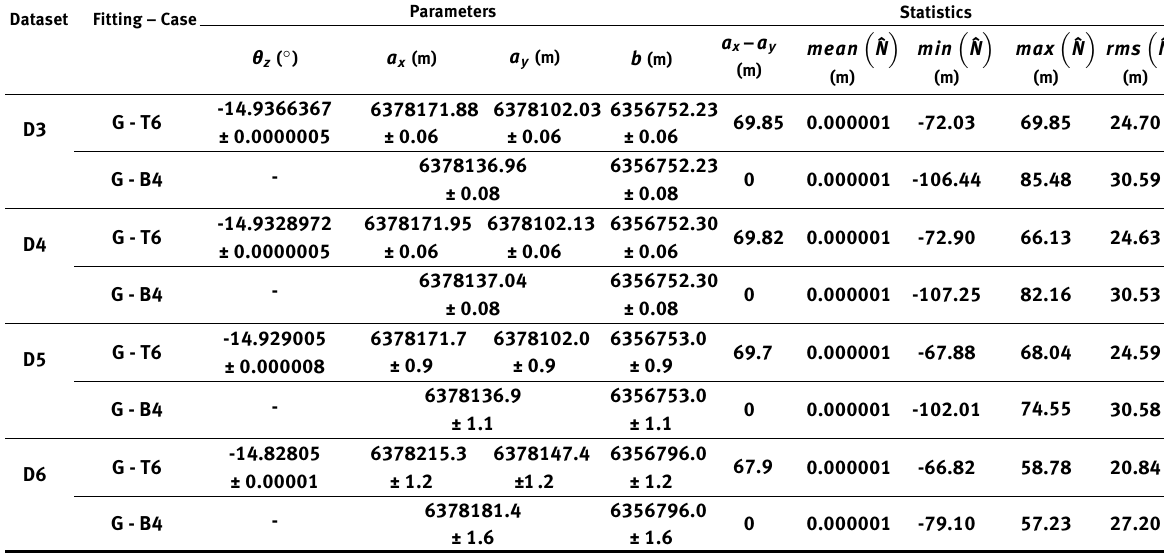
Table 8. Resulting values of the parameters and statistics of fitting for various geoid